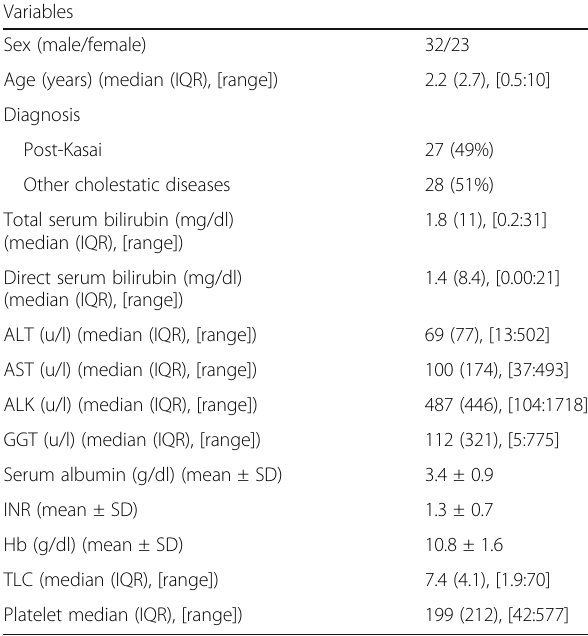
Table 1 Demographic and laboratory data of the cholestatic patients